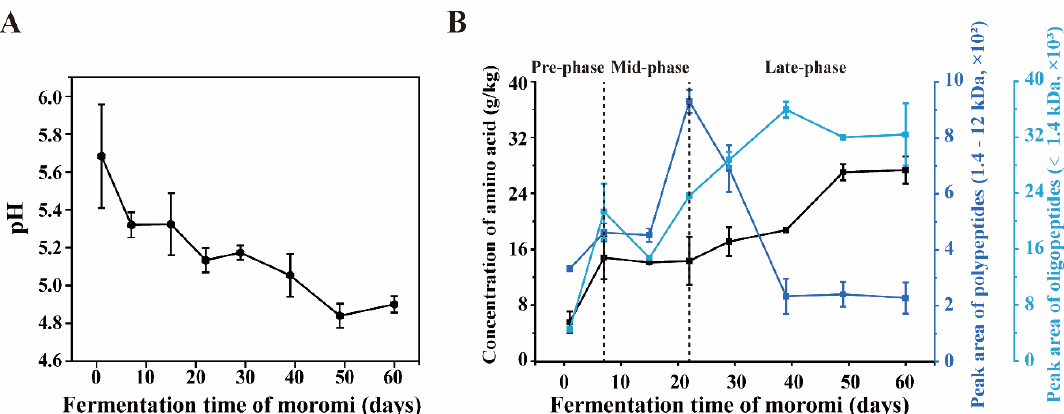
Figure 2. Physicochemical properties during the moromi fermentation. Dynamics of ( A ) pH and ( B ) polypeptide, oligopeptide and amino acid concentrations during the moromi fermentation.